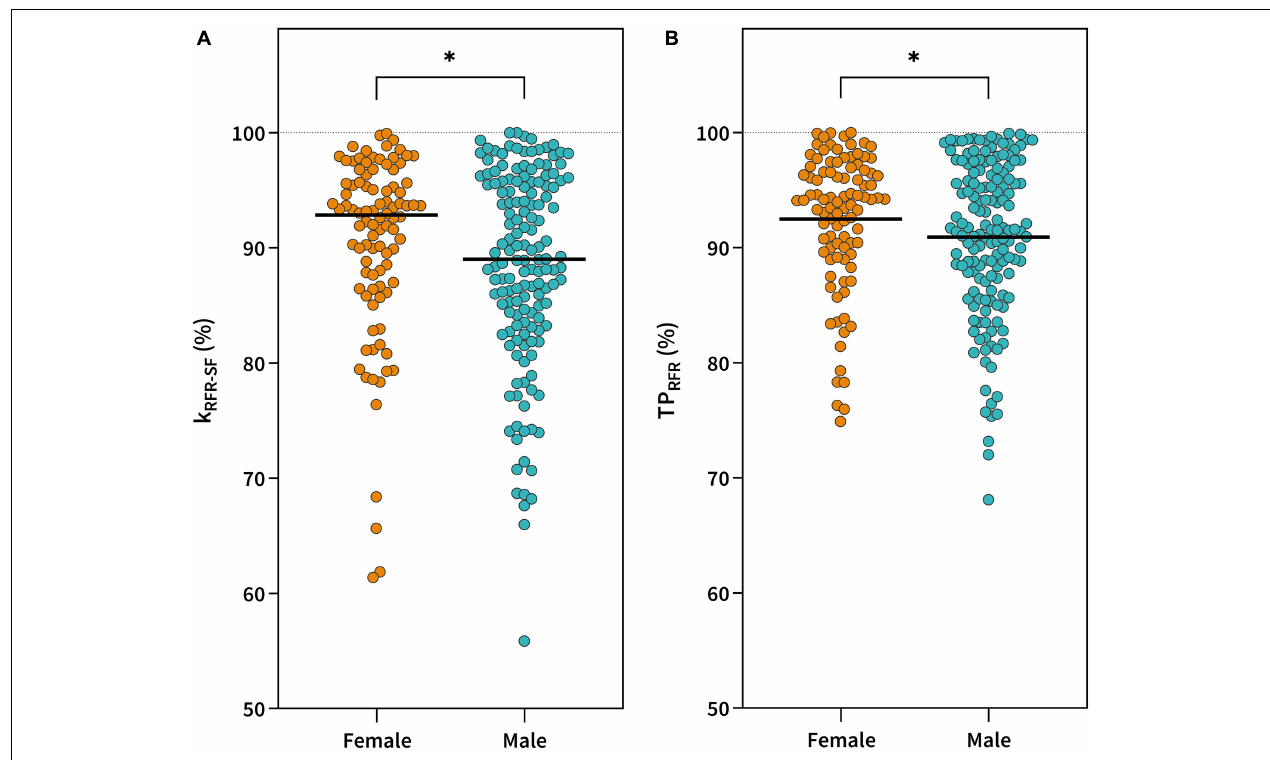
FIGURE 4 | Gender comparison in symmetry values for RFR-SF slope (k RFR − SF ) (A) and theoretical peak rate of force relaxation (TP RFR ) (B) . ∗ p <